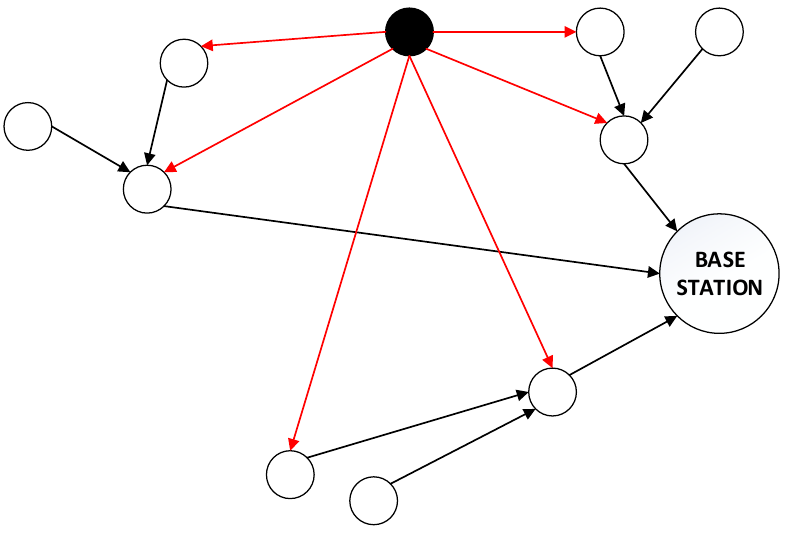
Figure 8. Demonstration of a Hello Flooding Attack.